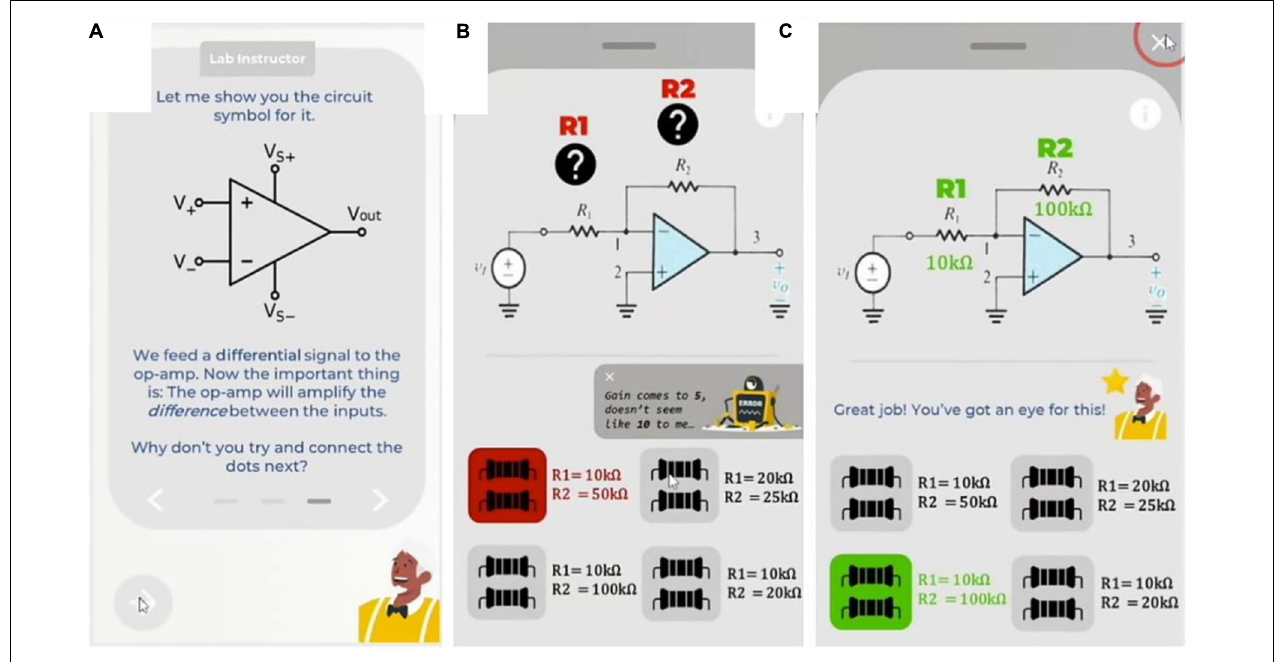
FIGURE 3 | Electronic design track sample showing concept introduction (A) and assessment (B) with immediate feedback (C) .